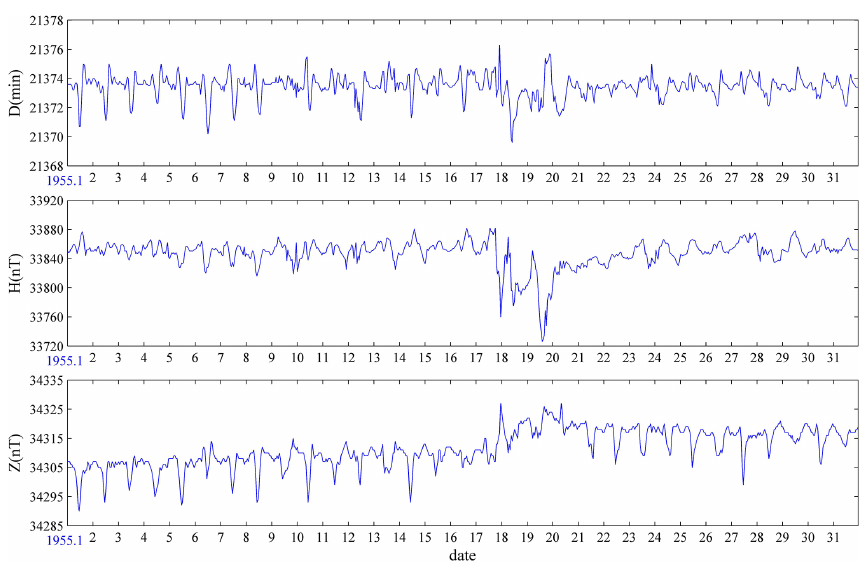
Figure 6. The AHMV record of January 1955 at SSH.